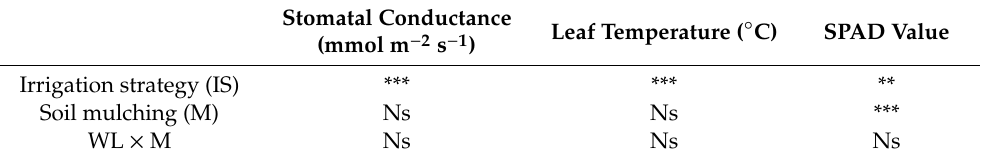
Table 8. Experiment 3: E ff ect of irrigation strategy and soil mulching on the physiological parameters of lettuce. Significance codes: *, significant at p ≤ 0.05; **, significant at p ≤ 0.01; ***, significant at p ≤ 0.001, “Ns” = not significant.